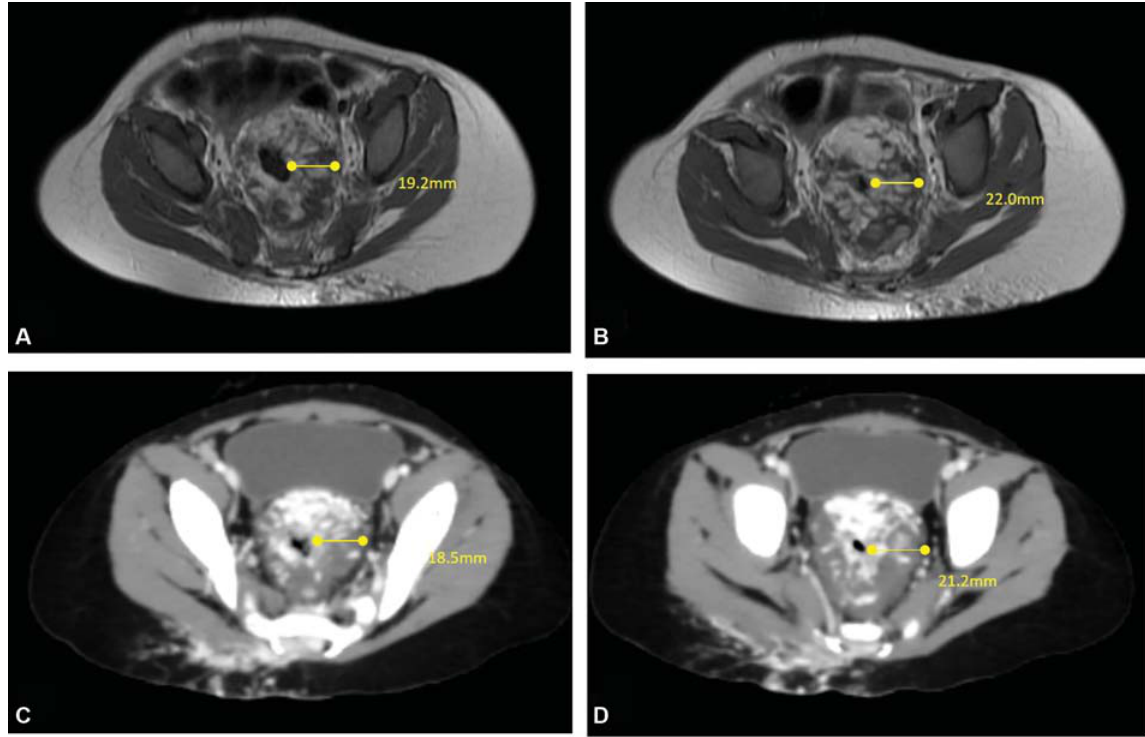
Fig. 2 Axial imaging demonstrating the deep pelvic component of the venous malformation. The venous malformation is seen totally encasing the anorectum with marked thickening of their walls almost occluding their lumen. The upper row ( A , B ): magnetic resonance imaging study performed before referral to our vascular clinic. The lower row ( C , D ): computed tomographic angiography performed 2 months later. Note the patchy and delayed contrast enhancement of the lesion typical for venous malformation. By comparing both studies (upper row with lower row), no appreciable changes could be detected in the deep pelvic component of the lesion in contrary to the external clinical